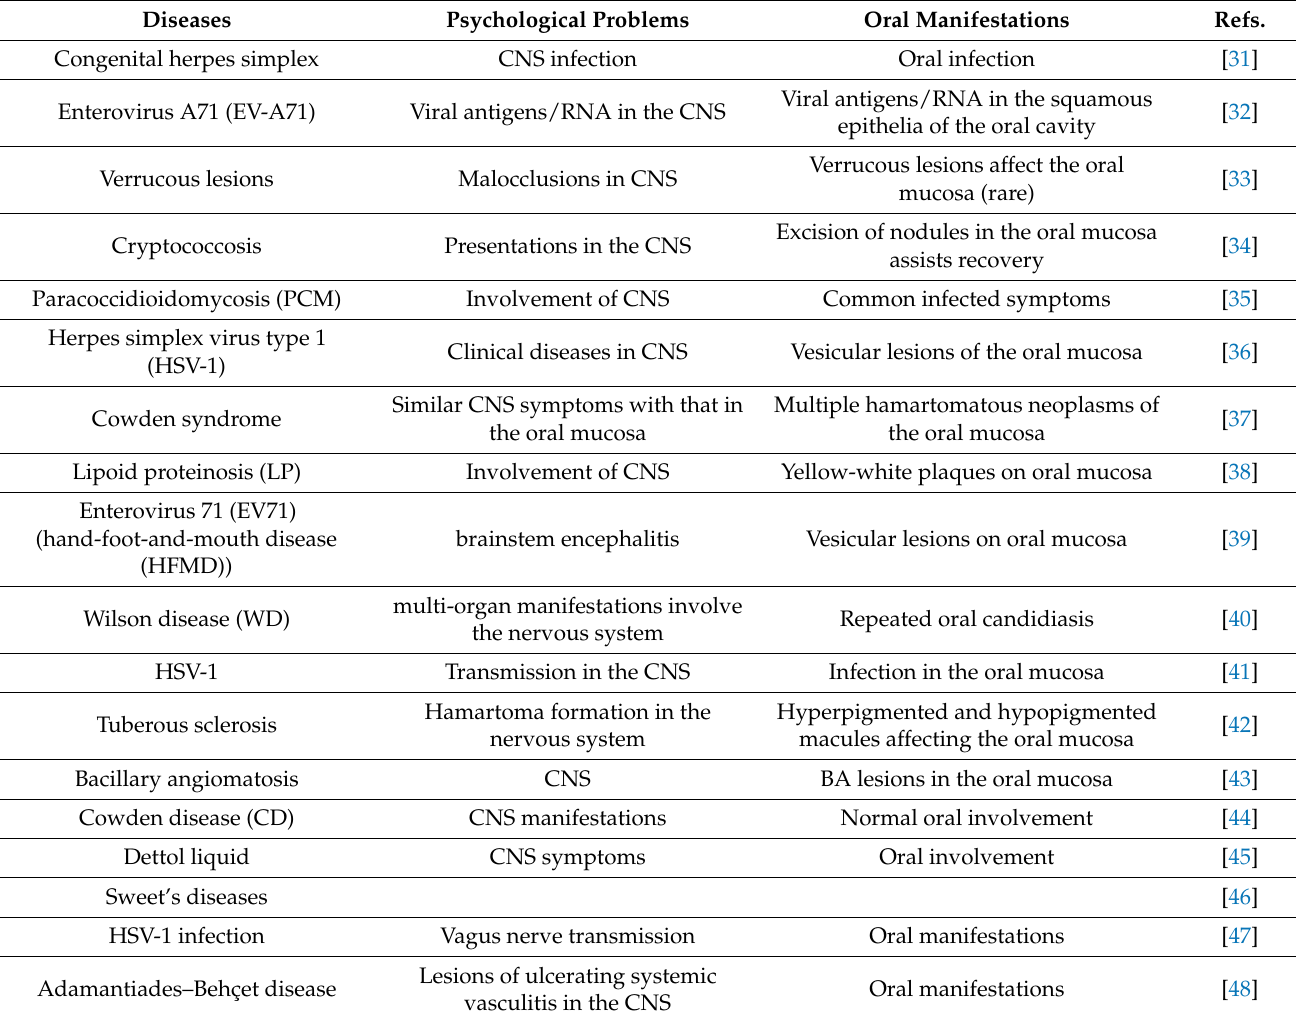
Table 3. Diseases with both the psychological problems and oral